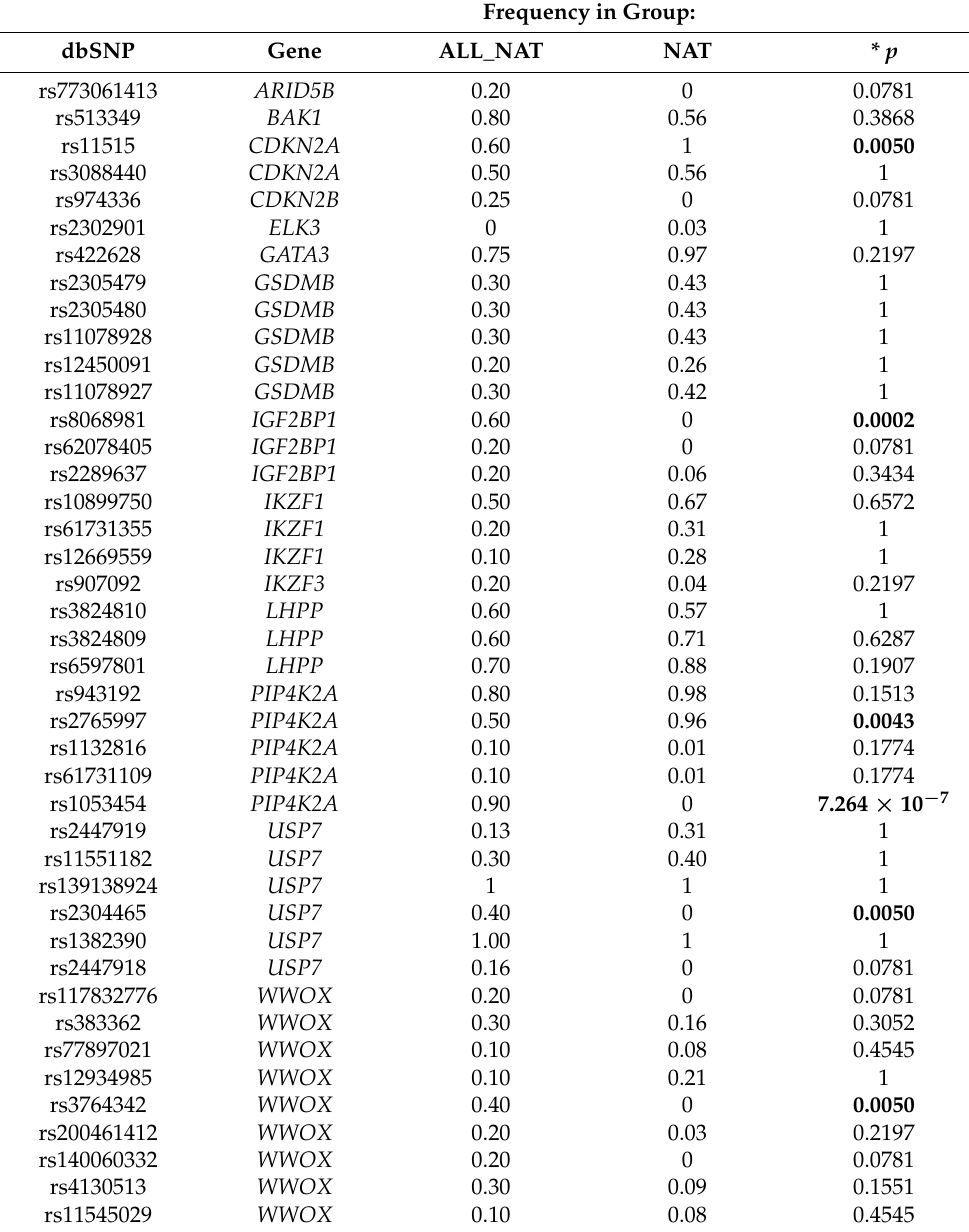
Table 2. Comparisons of the frequencies of the alleles investigated in the present study between the two Amerindian groups, that is, ALL patients (ALL_NAT) and cancer-free individuals